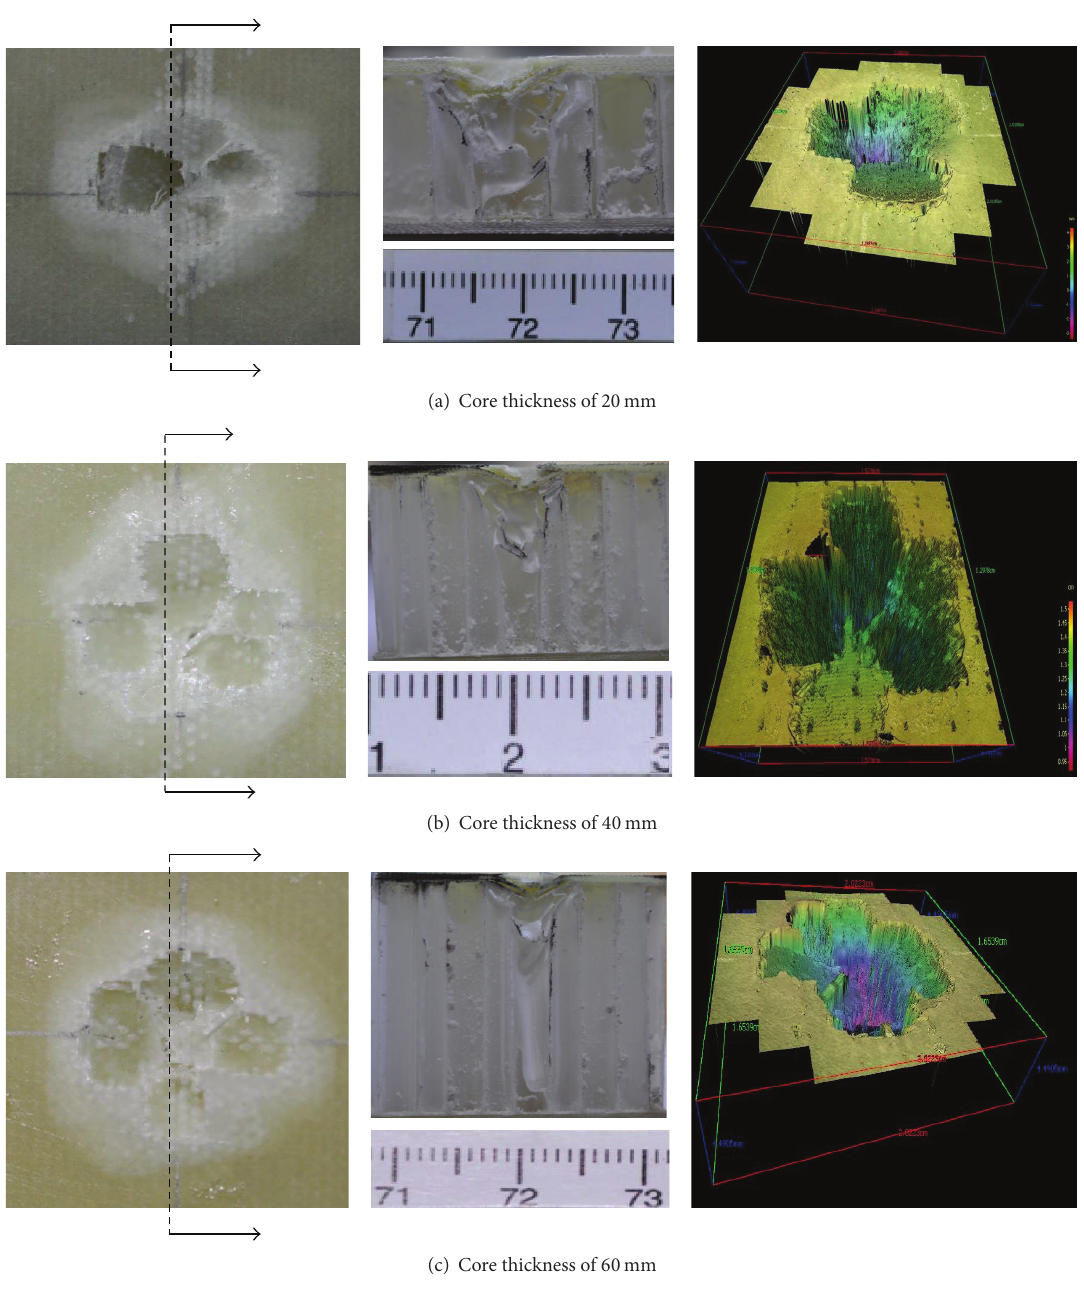
Figure 11: Impacted surfaces, cross-sectional views, and optical surface metrology of the sandwiches subjected to 15J of